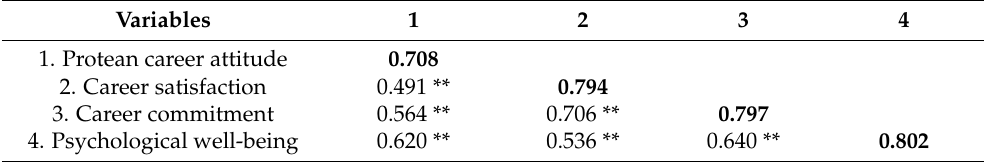
Table 3. Correlation and with the square roots of the average variation extracted at the diagonal. Variables